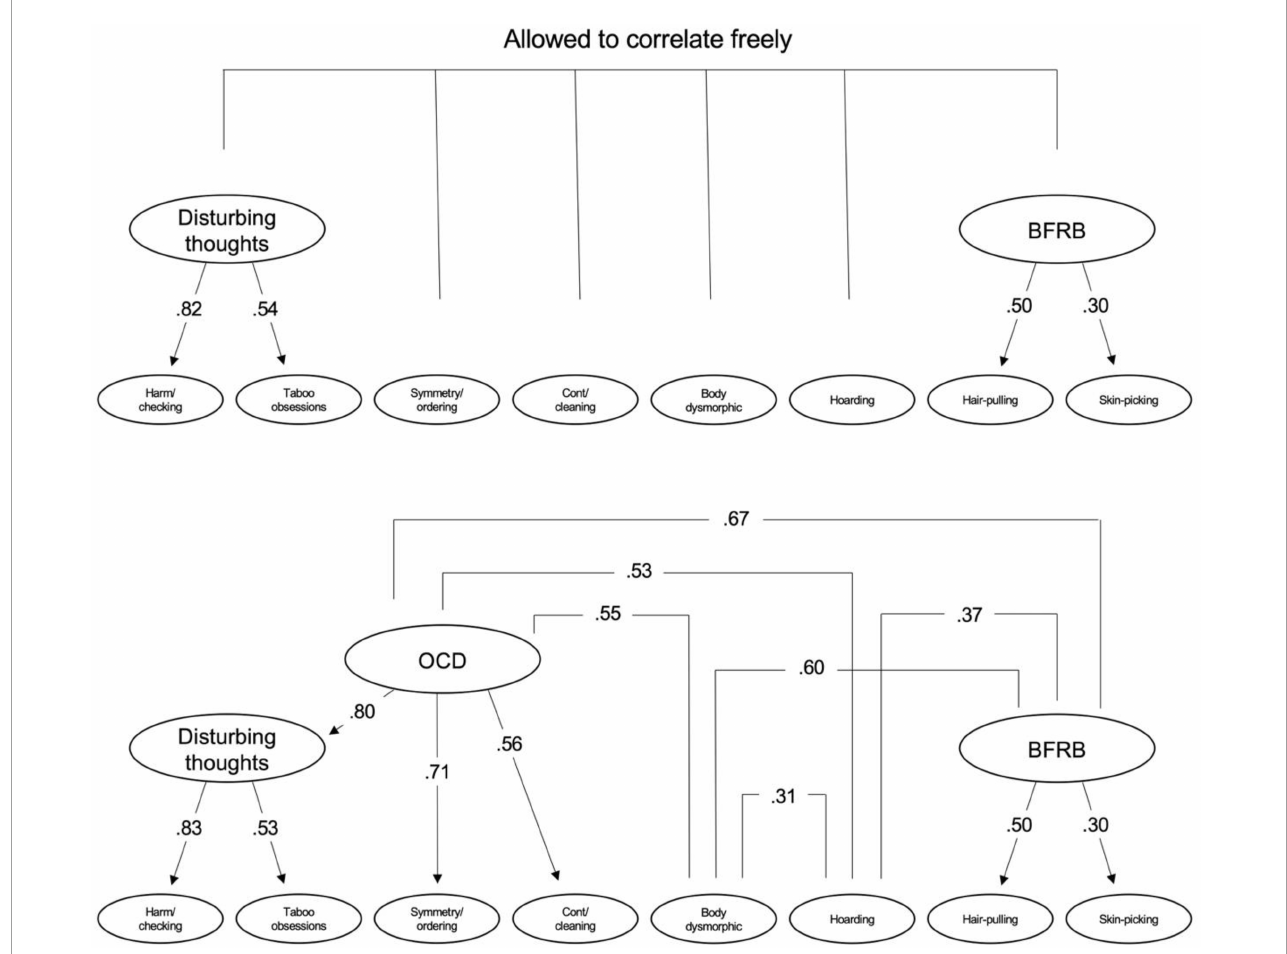
FIGURE1 At the top is a model where the empirically derived factors were allowed to correlate freely and at the bottom is a model where an overarching OCD factor is included which then is allowed to correlate freely with the rest of the factors. Correlations among the factors in the model at the top is presented in Table 4 and correlations among the factors in the model at the bottom are presented in this figure. BFRB, body-focused repetitive behaviors; OCD, obsessive-compulsive